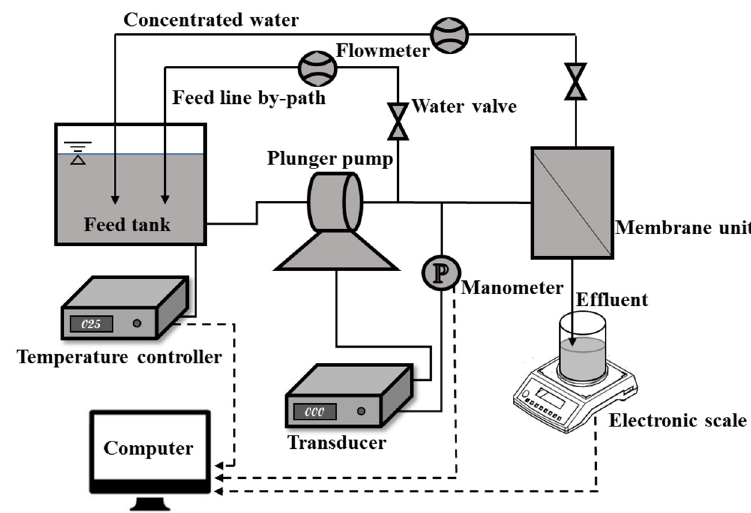
Figure 1. Continuous flow nanofiltration set-up.